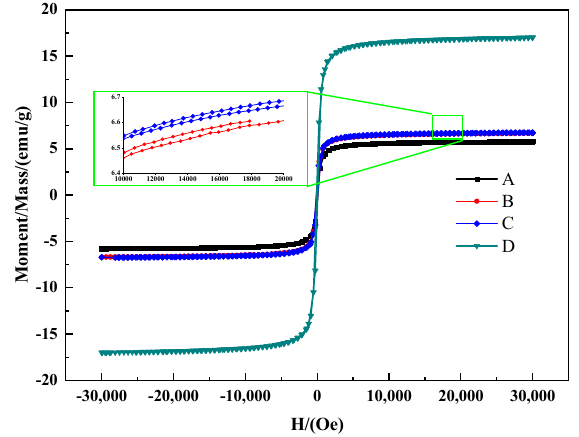
Figure 4. Curves of P(MAA/St)/Fe 3 O 4 prepared by polymerized microspheres with different carboxyl content on the surface: MP-1 ( A ); MP-2 ( B ); MP-3 ( C ); MP-4 ( D ).